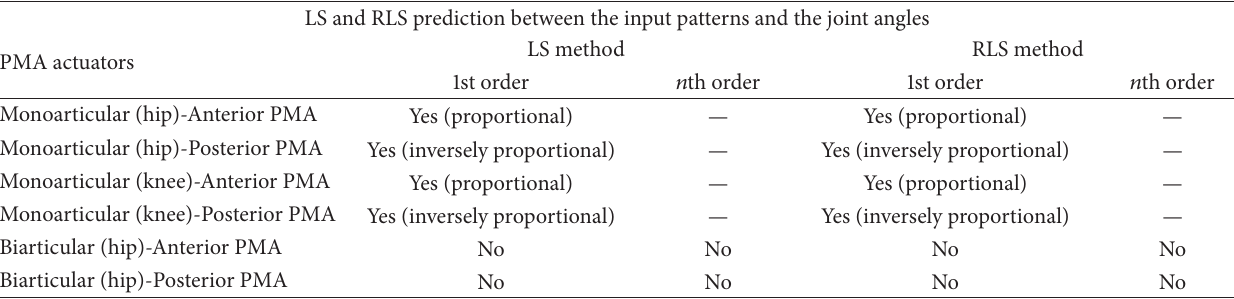
Figure 6: Schematic diagram of the exoskeleton of the AIRGAIT leg orthosis controller schemes. (a) Cocontraction model based P controller and (b) cocontraction model based PP controller, where ( 𝐶1 – 𝐶6 ) are the contraction input patterns, ( 𝐶𝑛1 – 𝐶𝑛6 ) are the corrected contraction input patterns, ( 𝑃1 – 𝑃6 ) are the pressure input patterns, and ( 𝑃𝑛1 – 𝑃𝑛6 ) are the corrected pressure input patterns. Table 2: Input patterns model verification using LS and RLS prediction